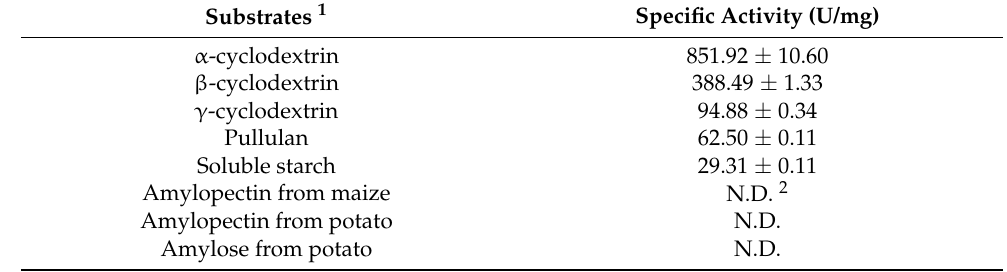
Table 1. Substrate specificity of Amy117. Substrates 1